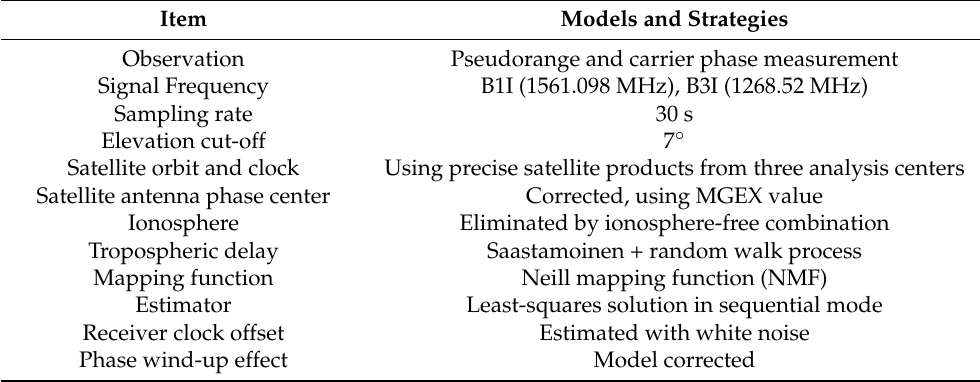
Table 2. Data-processing strategies in this